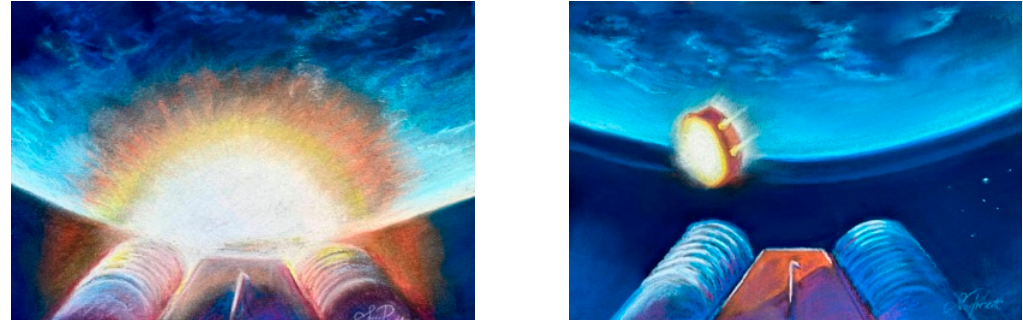
Figure 4. Leaving the problems of the Earth behind. As the Apollo 8 mission blasted through the Earth’s atmosphere, it held dreams of new frontiers not unlike visions of ‘terraforming’ Mars today. In the multibillion-dollar search for new worlds, none anticipated that history would soon be changed by nineteen cents worth of film and an unscheduled photograph of Earth, inspiring how we might better live on our own planet. Art by S.L.P inspired by video footage transmitted from the 1968 Apollo 8 mission.